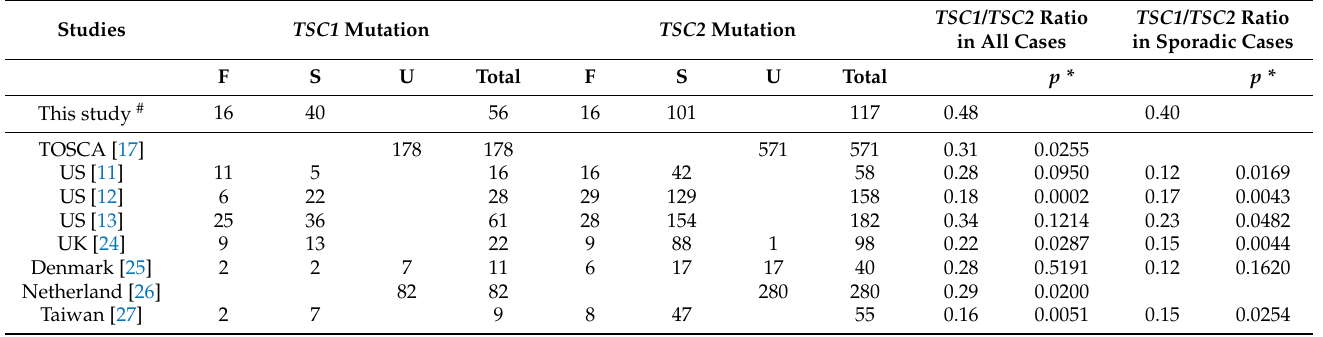
Table 5. TSC1 / TSC2 mutation ratio comparing between this study and previous large scale mutation